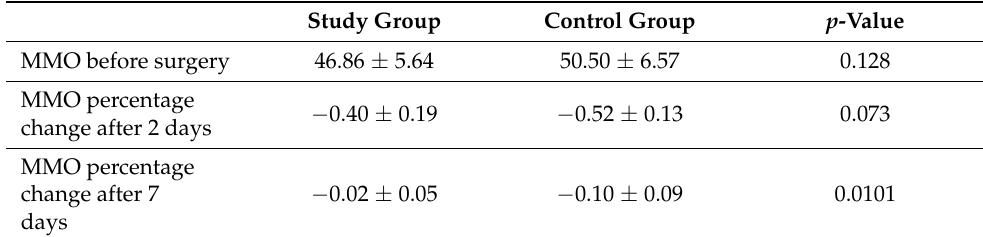
Table 3. Comparison of the maximal mouth opening in the test group (n = 15) and the control group (n = 15). Study Group Control Group p -Value